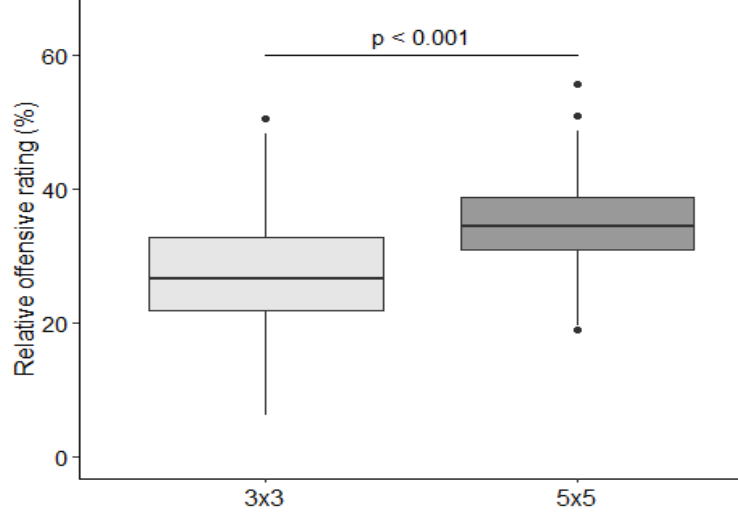
Figure 2. Relative offensive rating regarding basketball discipline.